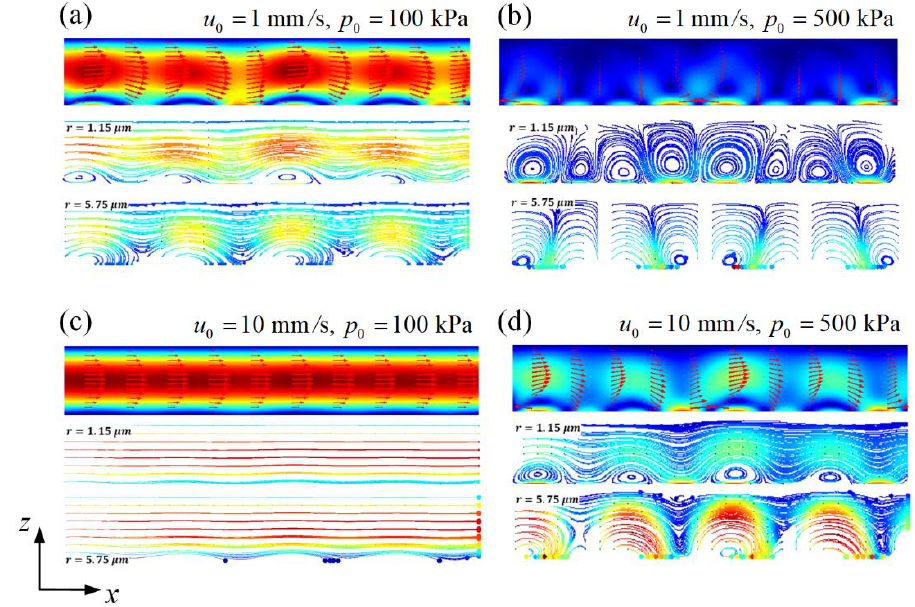
Figure 4. Flow field (top of the figure) and motion trajectories of particles with radii of 1.15 µ m (middle of the figure) and 5.75 µ m (bottom of the figure) at four different combinations of flow velocities u 0 and incident acoustic pressures p 0 : ( a ) u 0 = 1 mm/s and p 0 = 100 kPa ( b ) u 0 = 1 mm/s and p 0 = 500 kPa. ( c ) u 0 = 10 mm/s and p 0 = 100 kPa. ( d ) u 0 = 10 mm/s and p 0 = 500 kPa .